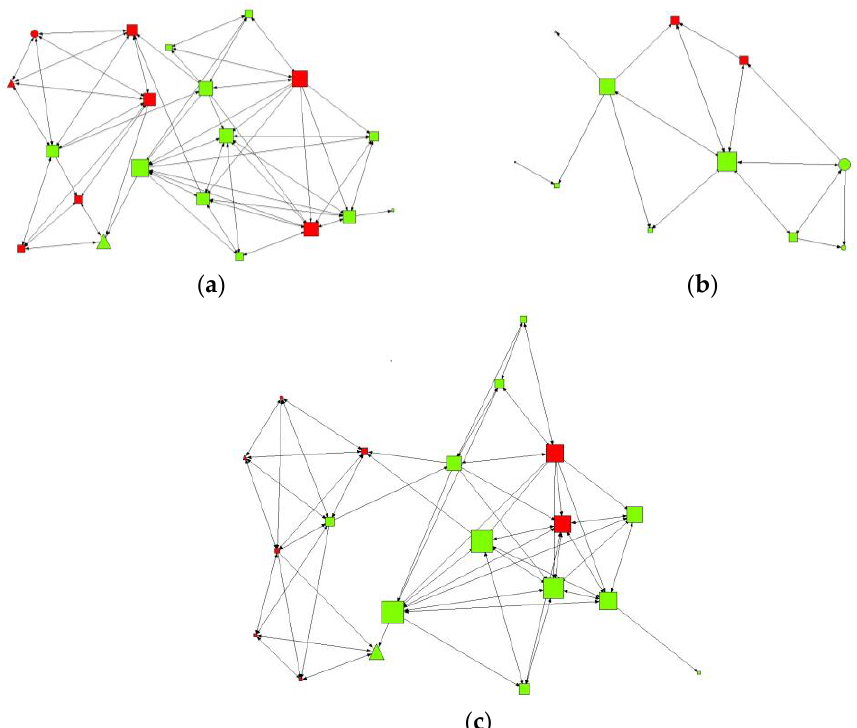
Figure 2. Structure of the friendship network and the study variables (i) Alcohol consumption and (ii) Self-efficacy. ( a ) Maximum contact intensity by degree of intermediation, ( b ) Maximum contact intensity by degree of closeness ( c ) Maximum contact intensity by degree of prestige/influence.